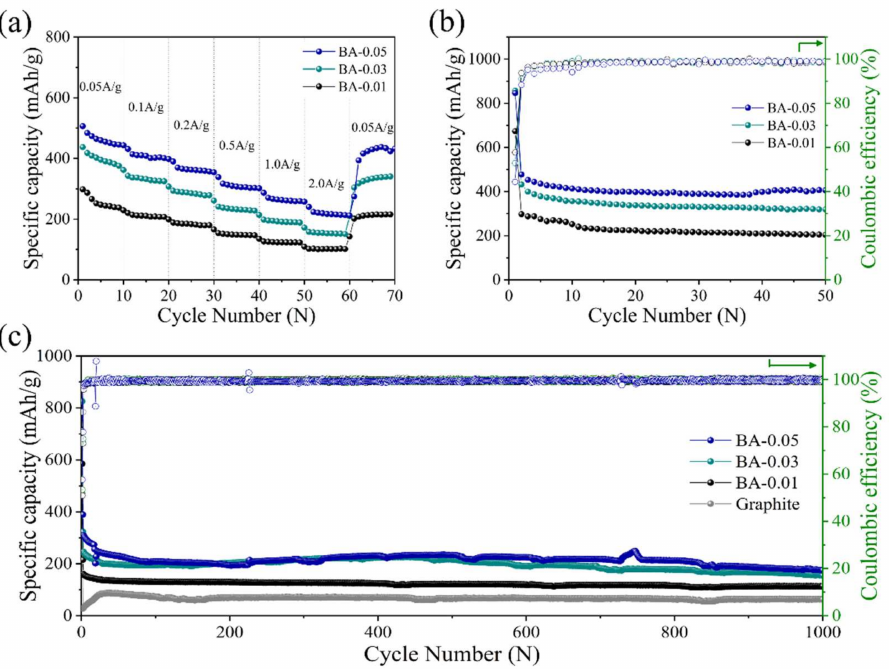
Figure 6. Battery performances of prepared banana stem electrodes; ( a ) Rate cycle capability at various current densities, ( b ) Cycle performance at a current density of 0.1 A/g for 50 cycles, and ( c ) long-term cycle stability at a fast-charging stage of 2 A/g for 1000 cycles compared to commercial